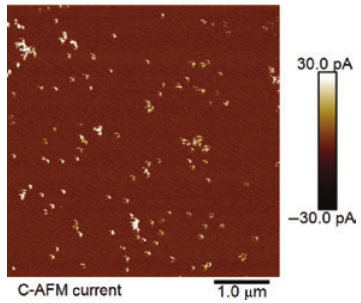
Figure 6: Conductive atomic force current image at 2.0 V of 93-nm-thick u-In Ga N layer reference 0.017 0.983